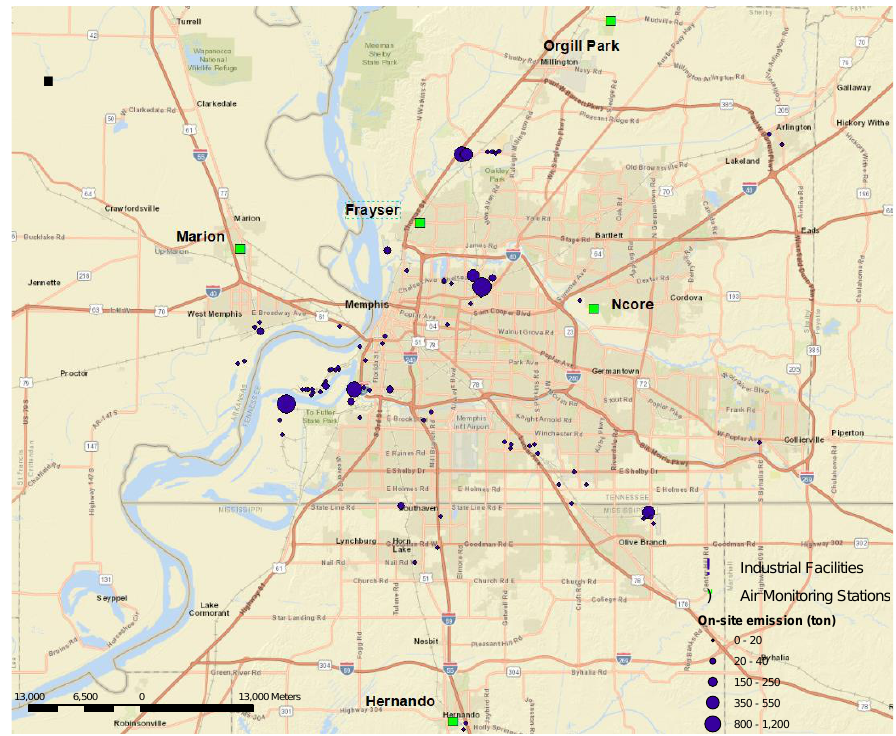
Figure 1. Ambient air monitoring stations in the Memphis Metropolitan Area.